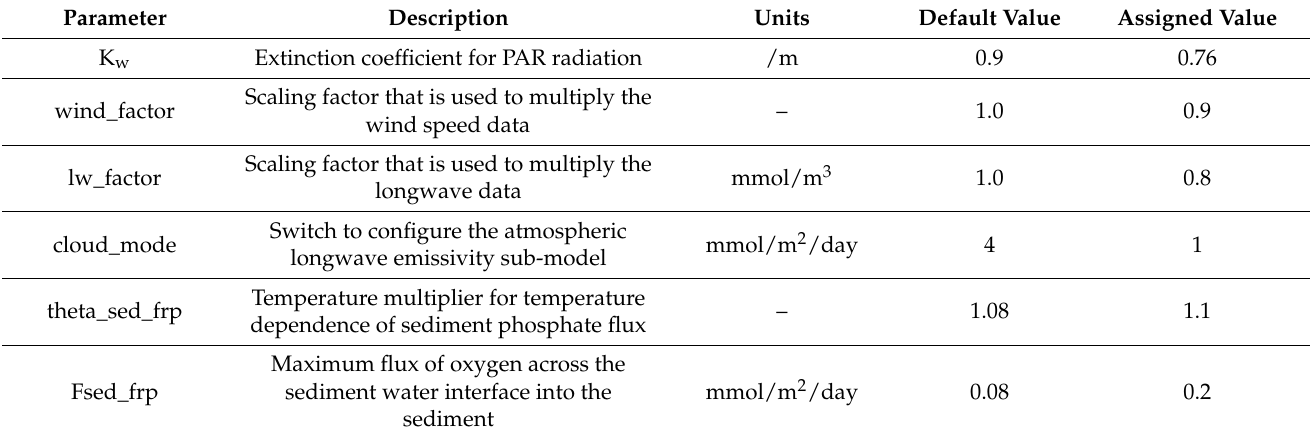
Table A3. Adjusted hydrodynamic and chemical parameters in